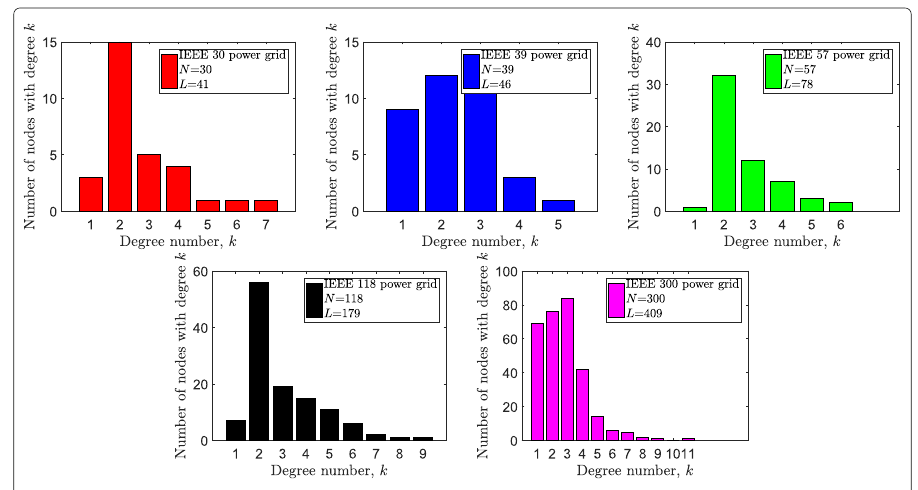
Fig. 2 The degree distribution of the simple graphs of 5 IEEE power grids